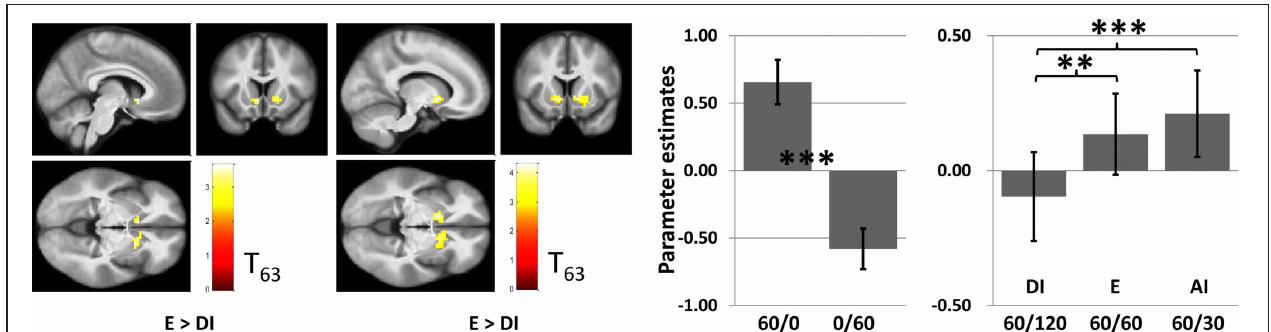
FIGURE 4 | Results for the ventral striatum. Left: Brain images showing significantly ( P < 0 . 005 for demonstration purposes) higher activation for E than DI (peakvoxel MNI-coordinates: X = − 6, Y = 14, Z = − 5), and for AI than for DI ( X = − 12, Y = 11, Z = − 5), within the functionally defined ROI. Right: The barplot shows mean parameter estimates for the different conditions averaged across all voxels of the functionally defined ROI. The left side demonstrates the strong responsiveness of the area to rewards per se (which was the selection